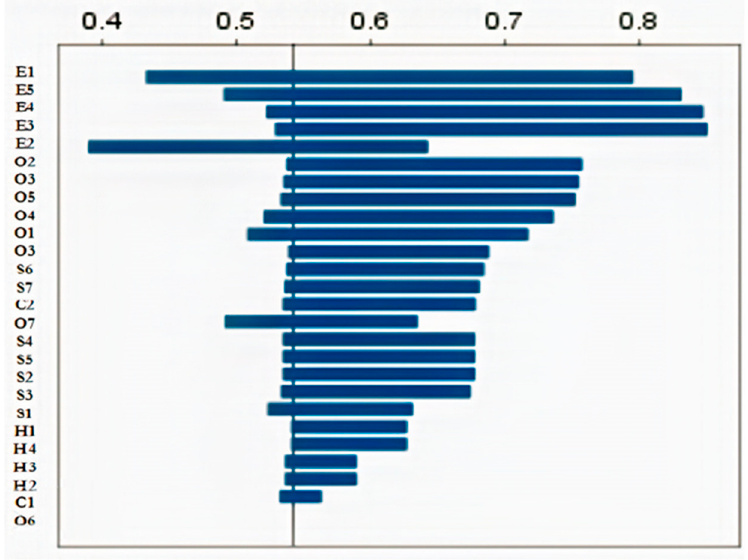
Figure 6. Tornado graph for sensitivity analysis of the risk of start-up X — Risk3 .